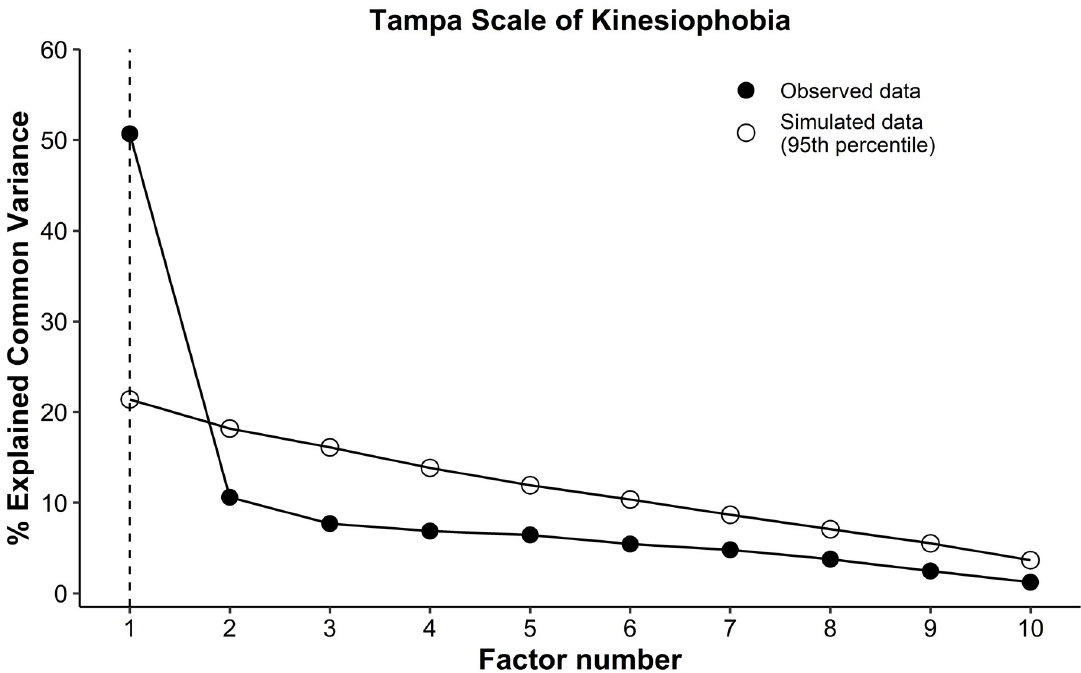
Fig 2. Parallel analysis of the Tampa Scale of Kinesiophobia indicated one-factor structure. The factor above the simulated data (95 th percentile) indicated the number of the factor in the structure.